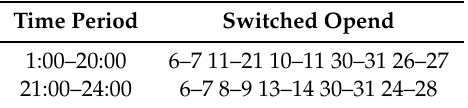
Table 4. Results of event triggered reconfiguration